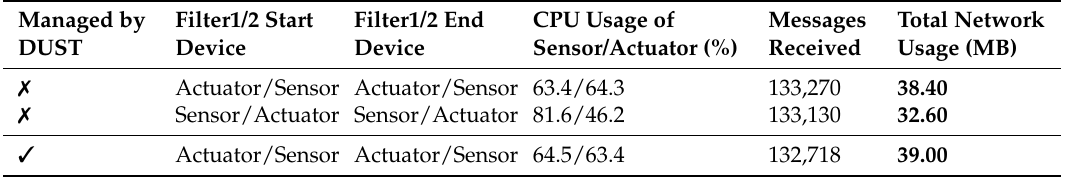
Table 5. The global optimisation